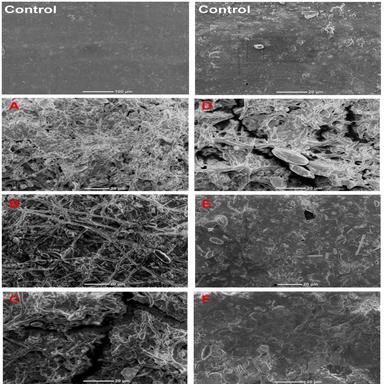
Scanning Electron Microscopy images from control (top) and six fabric samples (A–F) exposed to harsh environmental conditions for 14 months. The size of microscopic bar is indicated at each image.